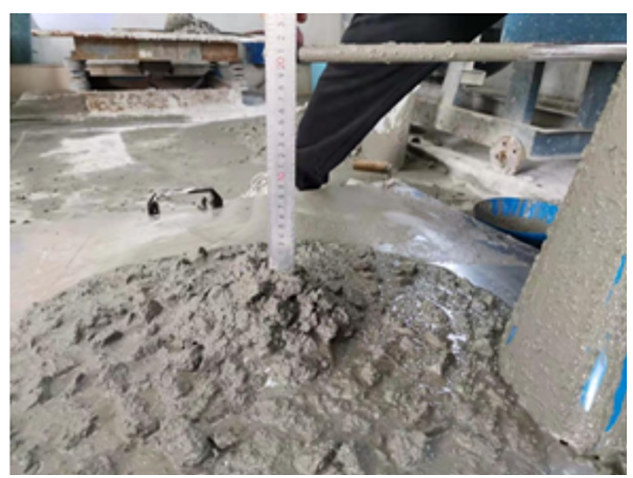
Figure 3. Test process diagram.